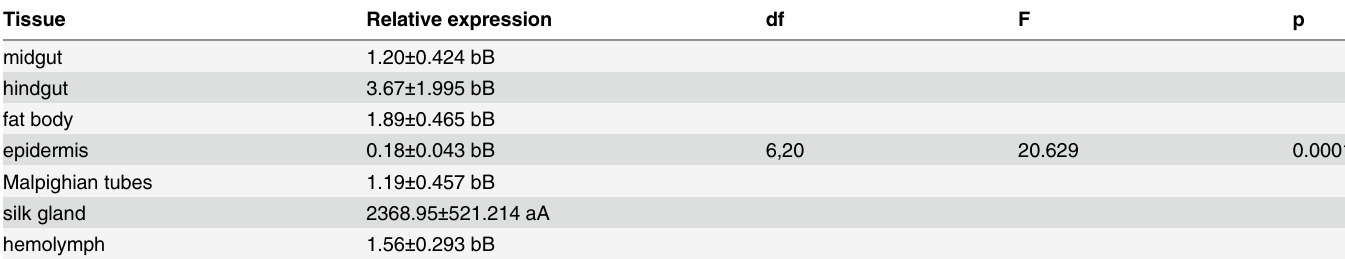
Table 7. Expression pattern of fibroin light chain gene in different tissues of